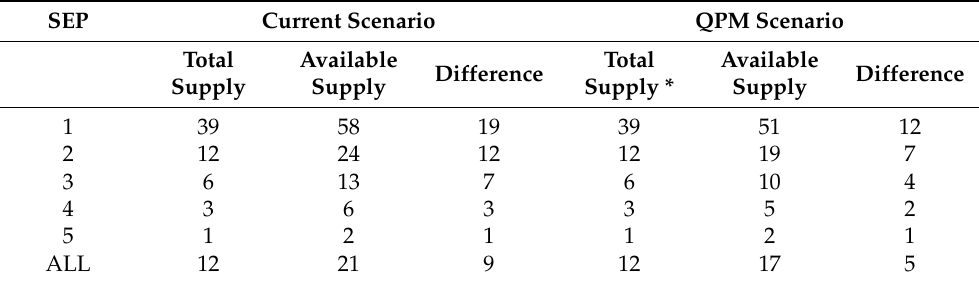
Table 4. The percentages of households at risk of protein deficiency due to inadequate dietary supply, including under a scenario with universal adoption of quality protein maize (QPM), stratified by socioeconomic